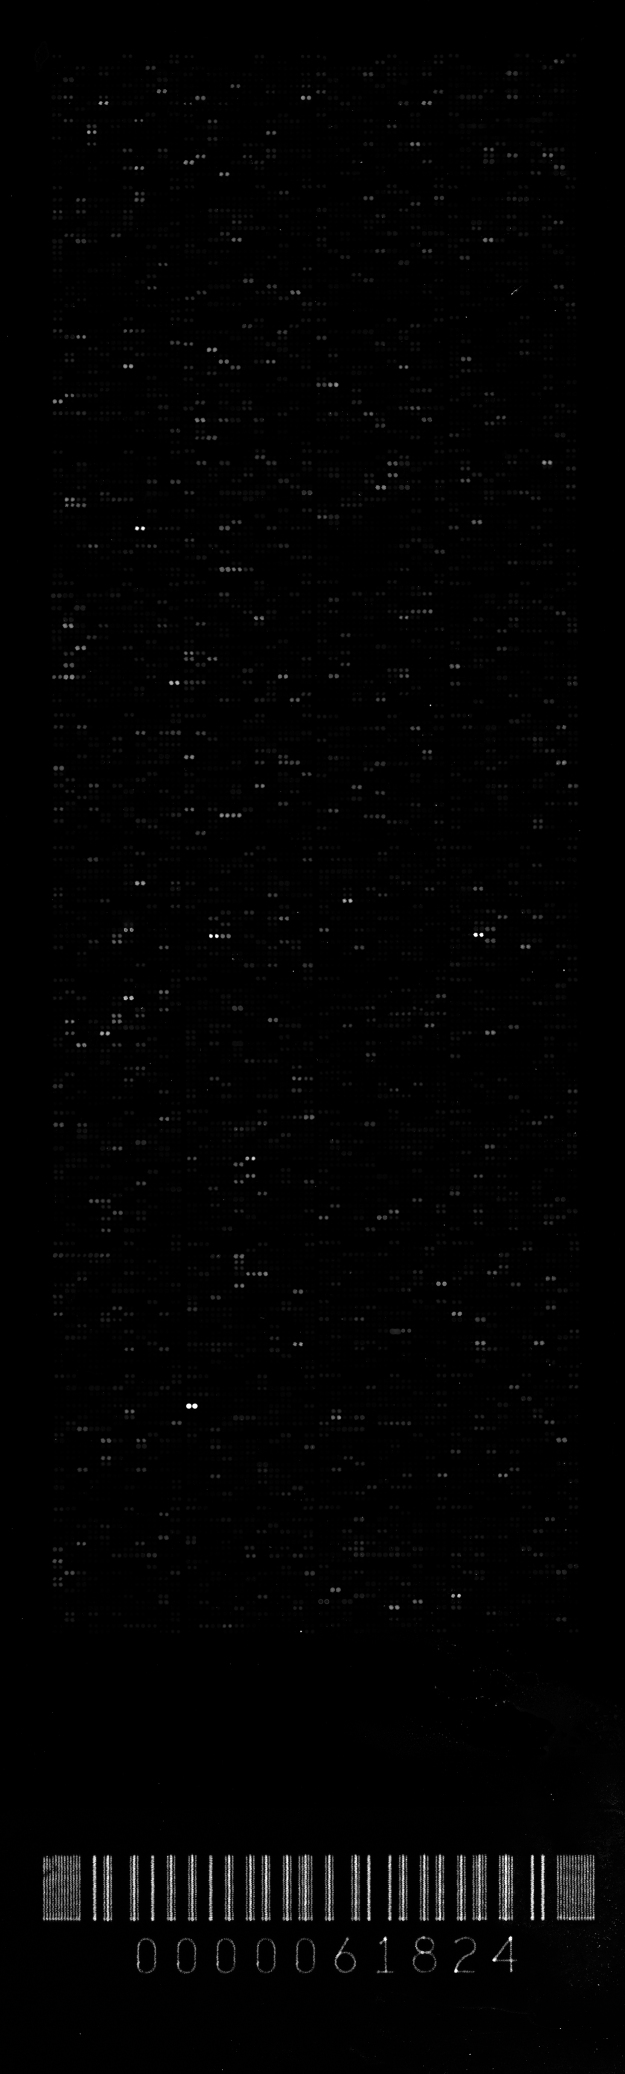
High Resolution Array Image. Experimental assay with G4-1, profiled at 2.5 μM.